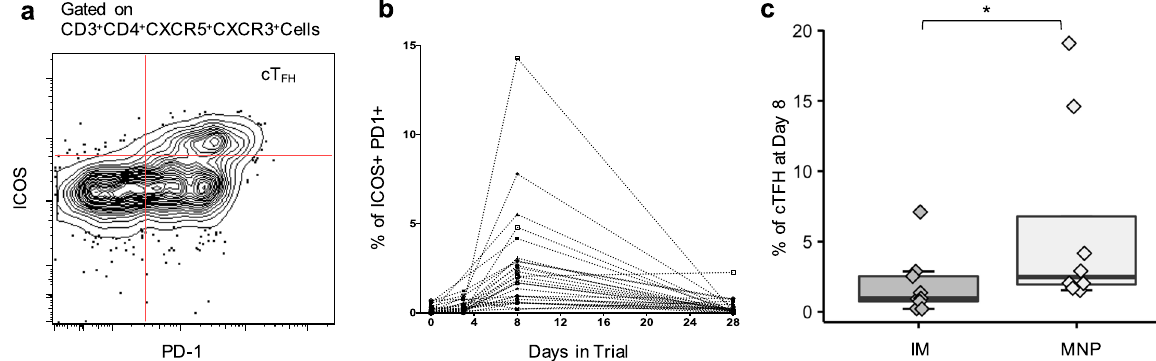
Fig. 7 Circulating T follicular helper (cT FH ) cells after vaccination. a Representative FACS plot showing ICOS and PD-1 co-expressing CD3 + CD4 + CXCR5 + CXCR3 + cT FH cells. b Temporal cells at baseline and days 2 – 3, 8, and 28 post vaccination. c Percentage of cT FH (CD4 + CXCR5 + CXCR3 + ICOS + PD-1 + ) at Day 8 post vaccination by vaccine delivery group (MNP: n = 8; IM: n = 9). The box portion of the plot represents the interquartile range (IQR: 25th percentile, median, and 75th percentile) of the data. Error bars represent smallest and largest values within 1.5 times IQR. Black lines indicate statistical signi fi cance based on Wilcoxon rank-sum test. * P < 0.05; ** P < 0.01. IM, IIV by intramuscular route; MNP, IIV by microneedle